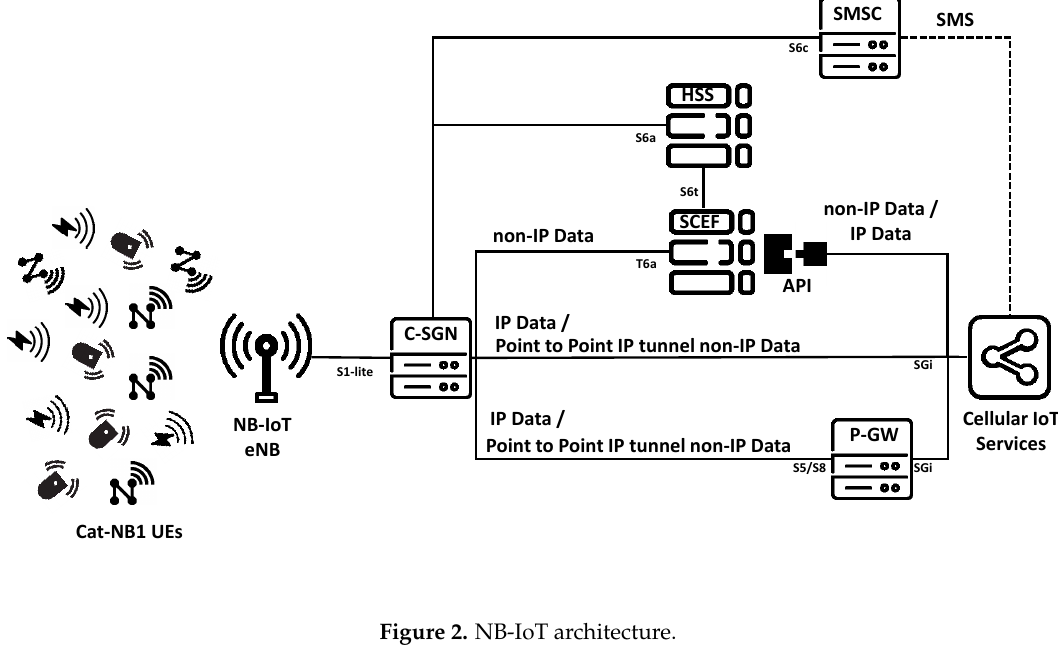
Figure 2. NB-IoT